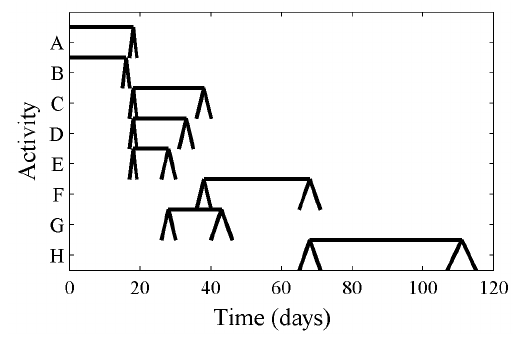
Fig. 8. Fuzzy Gantt Chart-2D without overlap